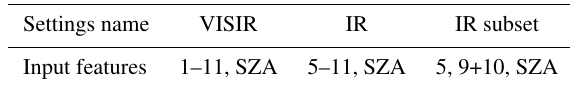
Table 2. Input features used for each input setting. Numbers are SEVIRI channels, and SZA is satellite zenith